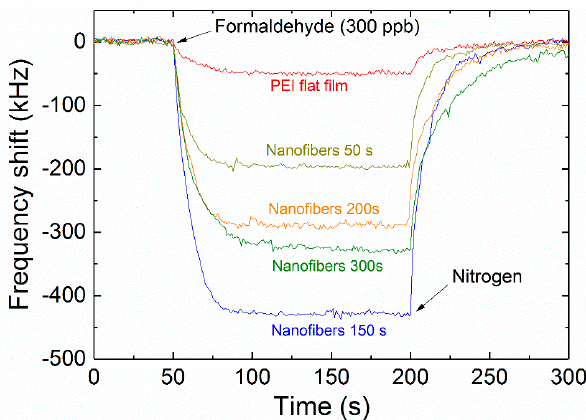
Figure 7. Time-dependent frequency response of the FBAR sensors coated with PEI flat film and different amounts of PEI nanofibers when exposed to 300 ppb formaldehyde vapor. All the tests were performed at room temperature and 40% relative humidity.